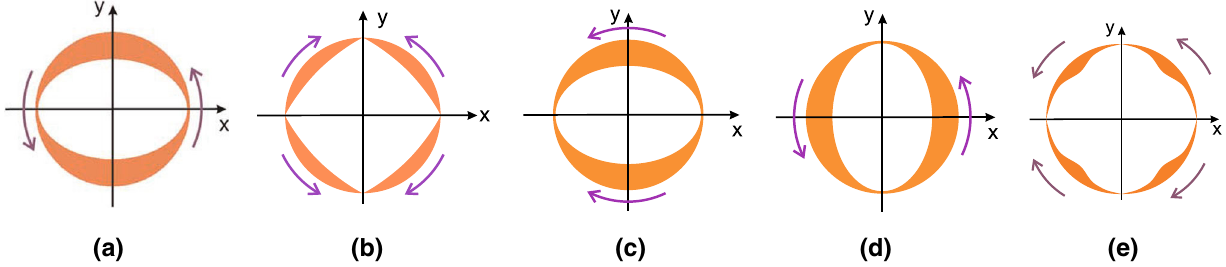
Fig. 6 The angular distribution (in the cylindrical polar coordinates) of the strengths and “rotational directions” of the PPFs, produced by the HFGWs having different polarization states. Here, for subfigures a – e , we have n n ( 1 ) φ ∝ sin φ cos 2 φ , respectively